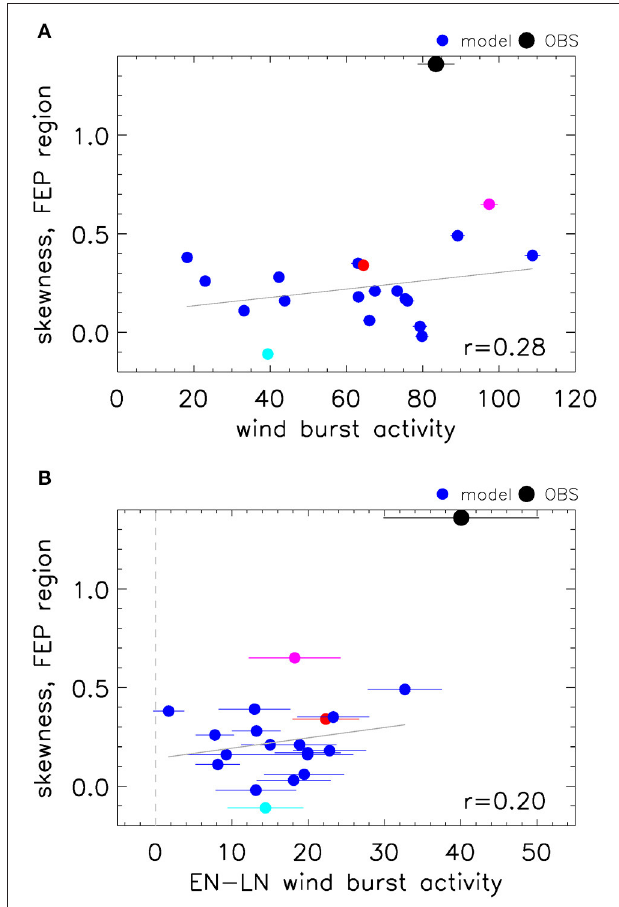
FIGURE 3 | Relationship between skewness and westerly wind burst activity. Scatter diagram of FEP SST skewness against annual mean wind burst activity (A) and against the El Niño minus La Niña difference in wind burst activity during the January to November period prior to ENSO events (B) for PPE members (small blue circles, with SK + magenta, STD red, SK– cyan) and reanalysis data (large black circle). Horizontal bars show the standard error.